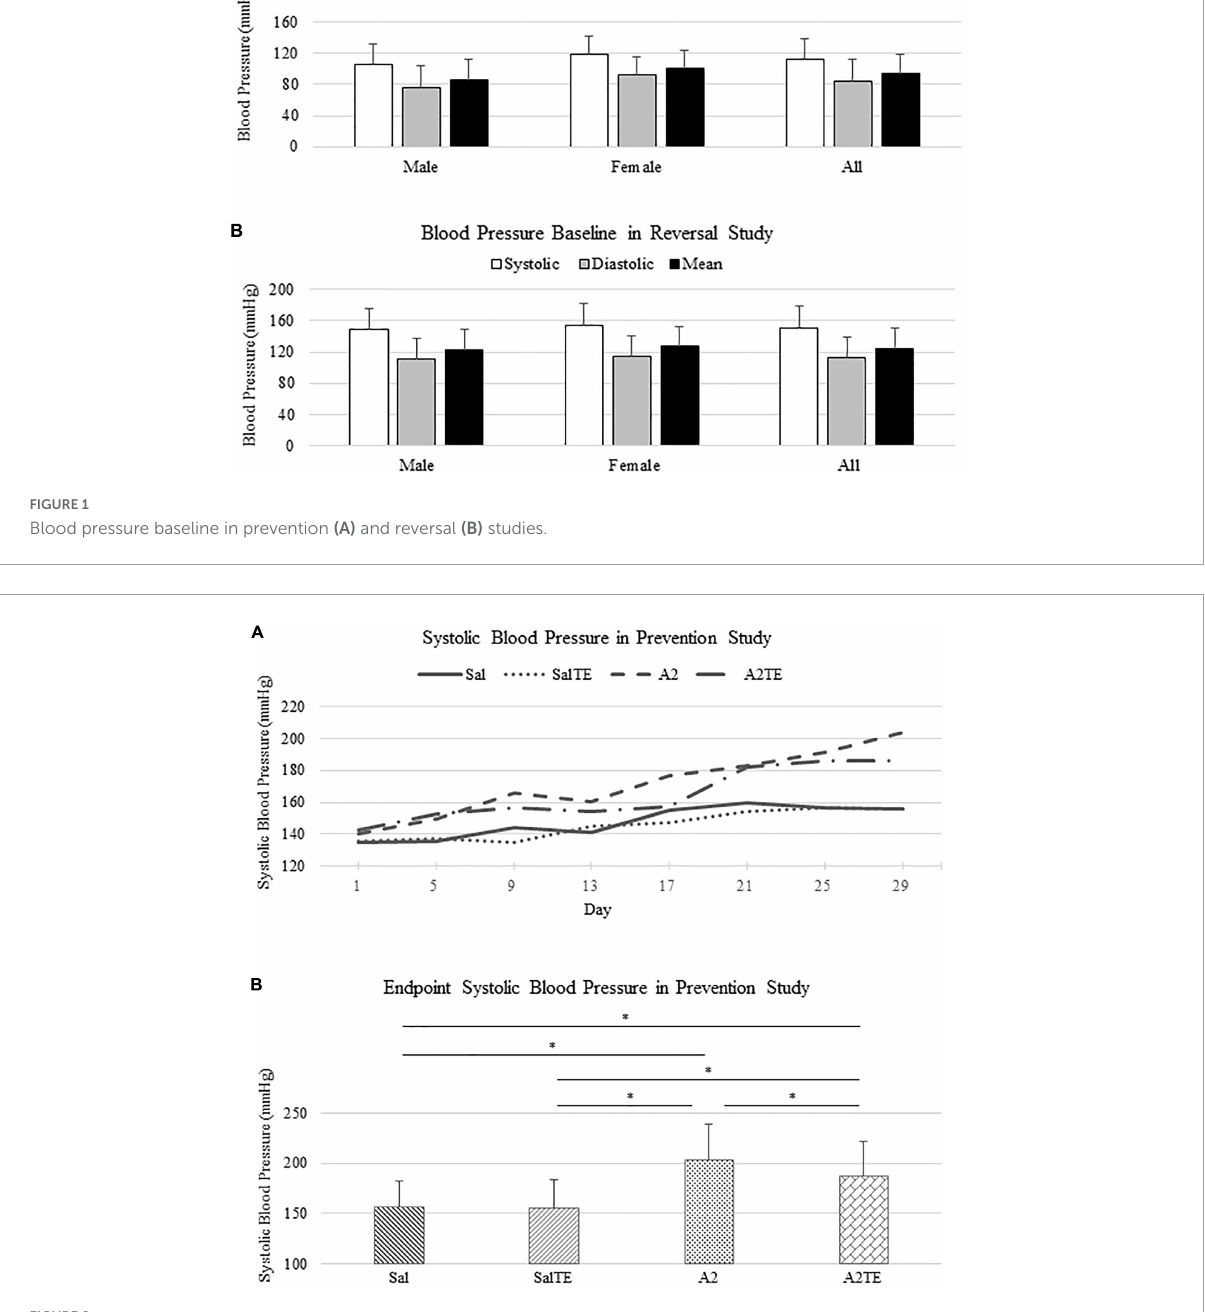
were significantly higher than those from saline groups (Sal and SalTE) ( Figure 3B ). After 2 weeks along with TE administration (Day 41), blood pressure was continuously increased by A2, but